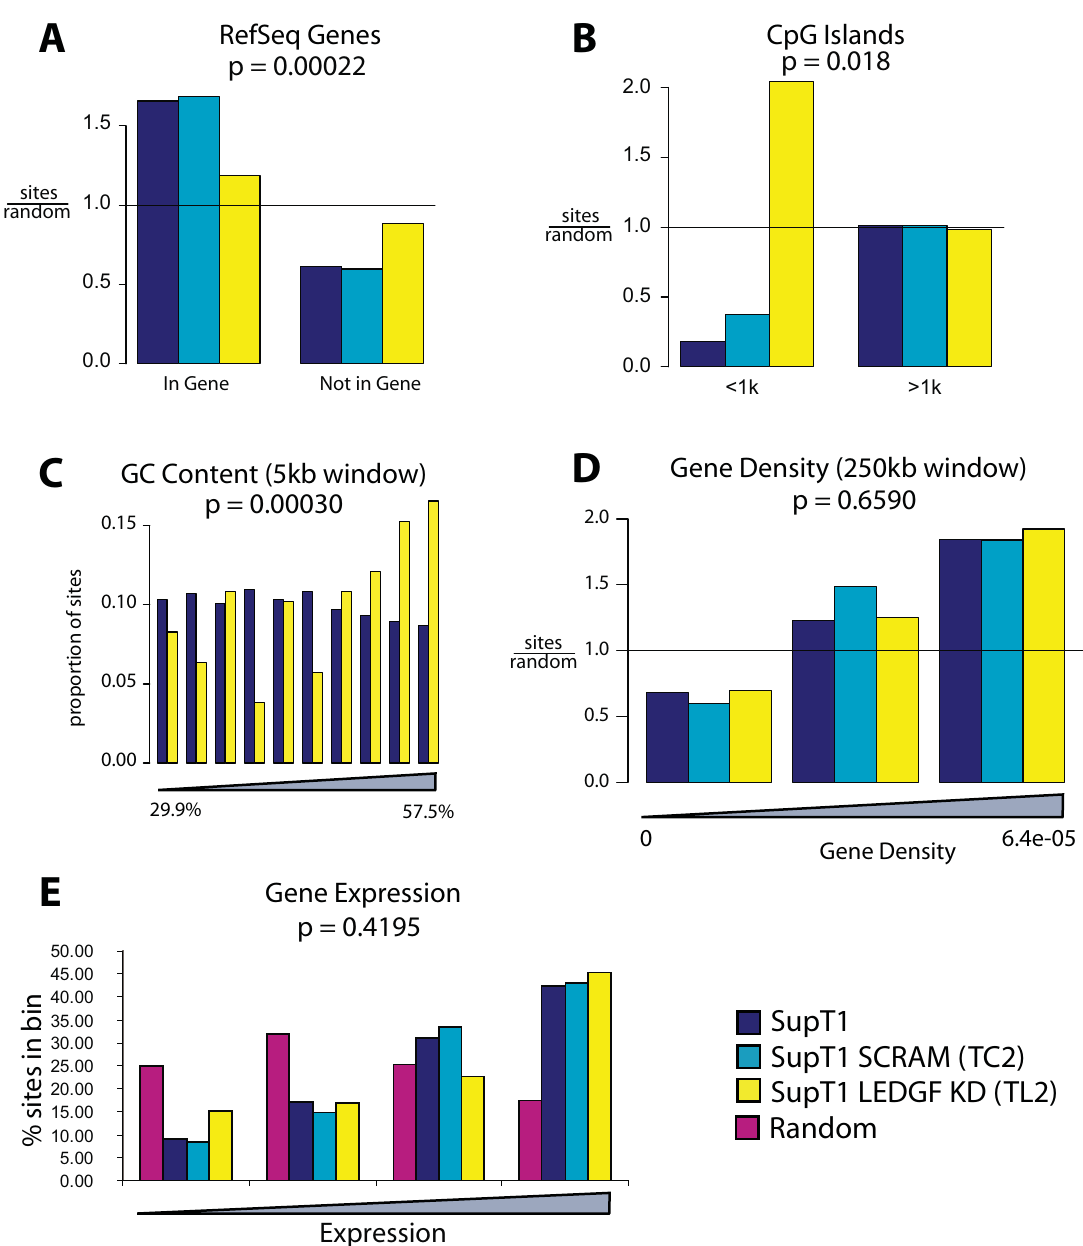
Figure 4. EIAV integration site distributions in control and LEDGF/p75-knockdown SupT1 cells. Integration site distributions are shown relative to A) RefSeq genes, B) CpG islands (plus or minus 1 kb), C) relative G/C content (Integration sites from unmodified and knockdown cells were pooled and divided into 10 equal bins of increasing GC content, and sites in each cell type plotted for each bin), D) gene density, and E) relative gene expression intensity. For each value in A–B) and D), the measured value for the integration site population was divided by that of the matched random control to emphasize the departure of the experimental data from random. P values shown are based on regression analysis (A–C) or Chi Square test for trend (D–E). lines show different steady state levels of LEDGF/p75 mRNA. Different cell types also show reproducibly different frequencies of HIV integration in transcription units (see [40] for examples). We thus asked whether cell types with higher LEDGF/p75 levels showed higher frequencies of HIV integration transcription units.